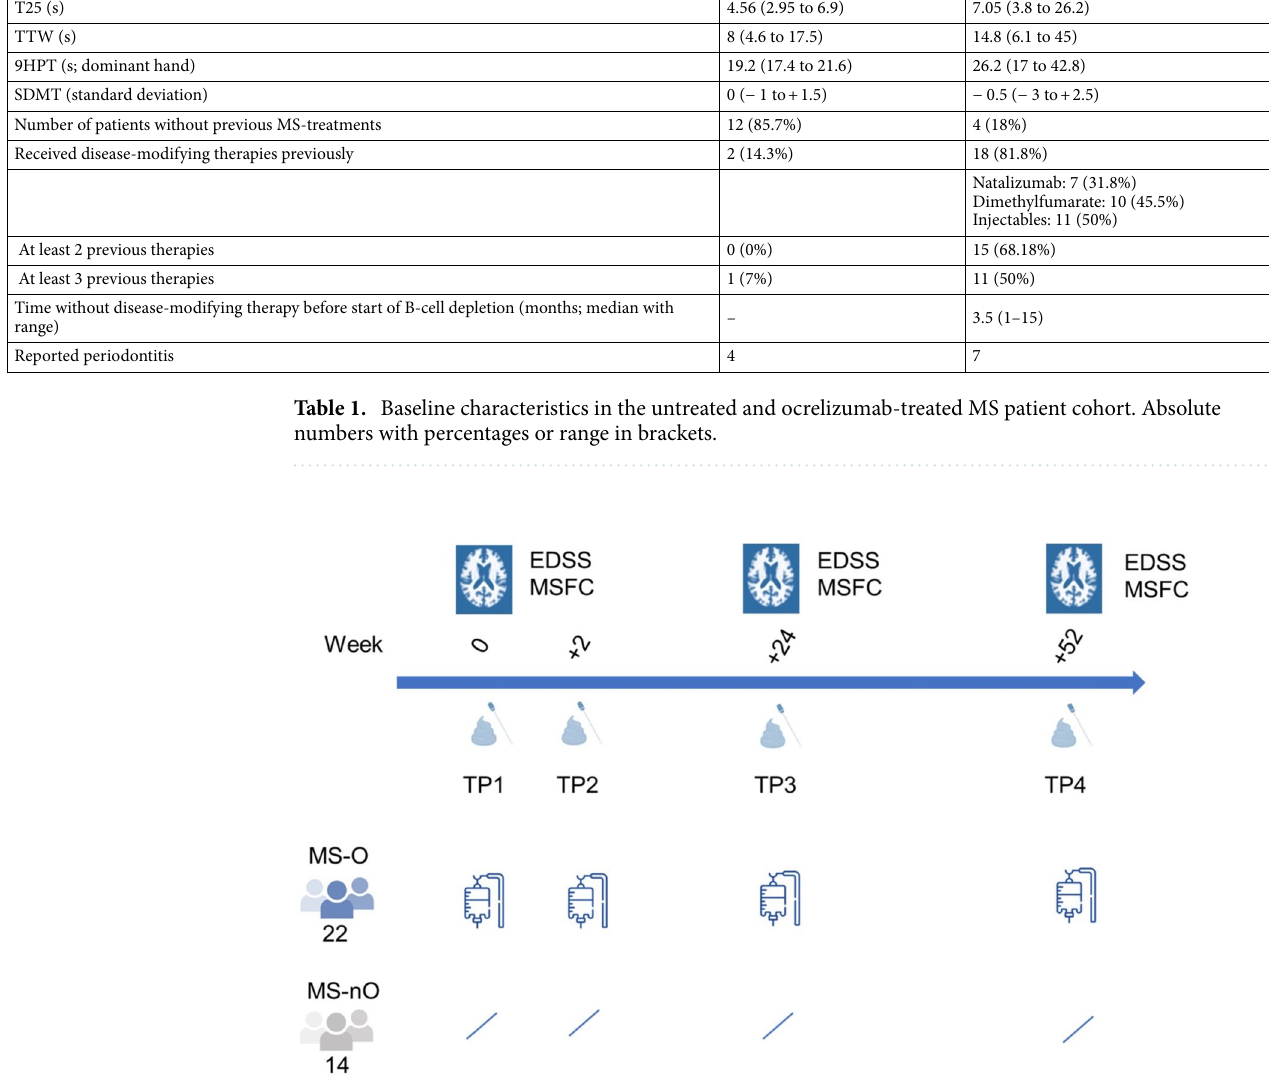
Figure 1. Study design. 37 MS patients, of whom 22 initiated B-cell depletion therapy with ocrelizumab and 14 age- and gender-matched untreated MS patients were recruited for this observational study. Four timepoints (days 0 and 14, weeks 24 and 52) over 12 months were analysed including microbiota analysis of provided stool and oral swab samples as well as clinical outcome and MRI